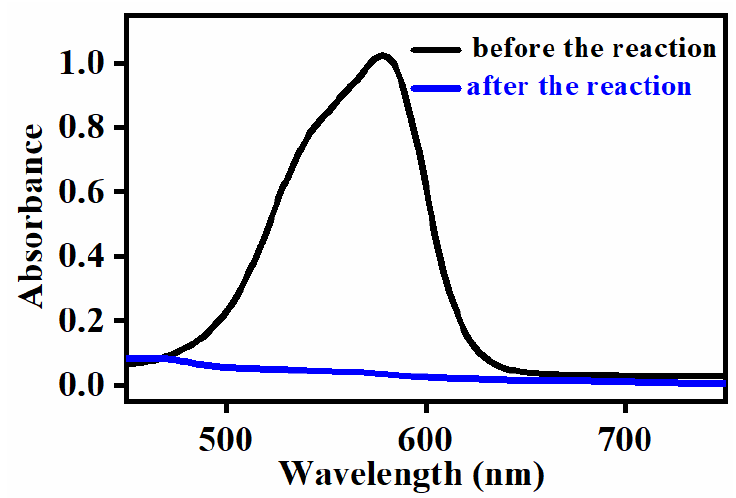
Figure 3. UV–vis spectral change in gentian violet before degradation (black line) and after degradation (blue line). Conditions: gentian violet 0.05 mM, [Fe III (TCPP)] 0.005 mM, PhIO 5 equiv, solvent MeOH, 303 K and reaction time 2.5 h.